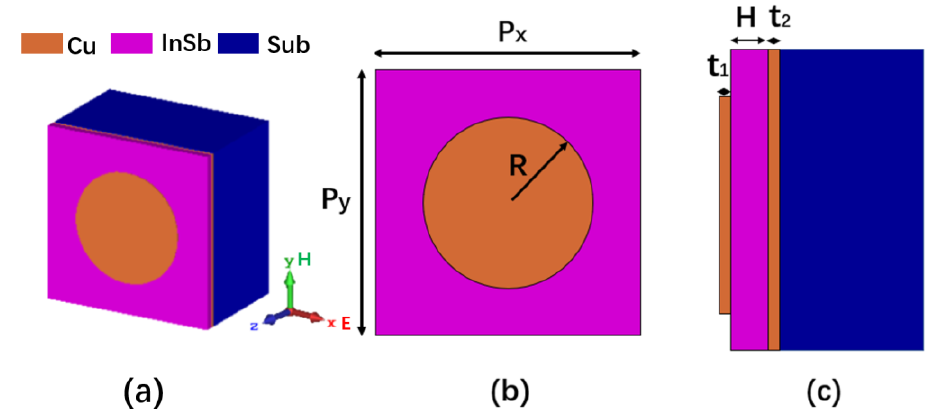
Figure 1. ( a ) Unit structure diagram of the proposed absorber, ( b ) top view of unit cell structure, ( c ) side view of unit cell structure. The structure parameters are: Px = Py = 50 µ m, R = 16 µ m, H = 3 µ m, t 1 = t 2 = 0.4 µ m.